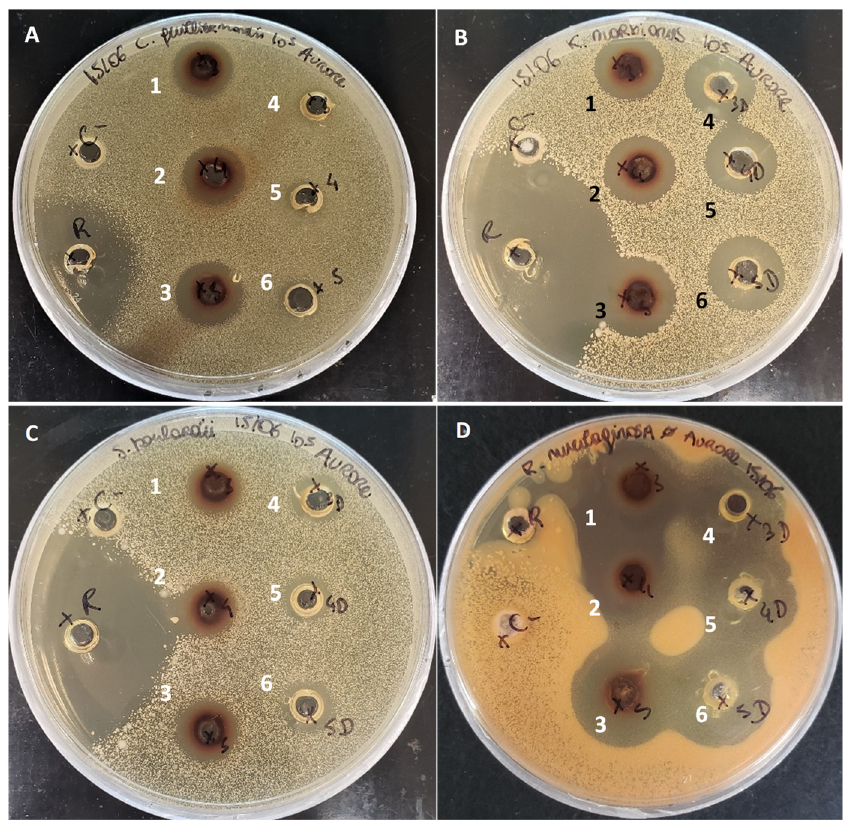
Figure 6. Inhibition zones for yeasts C. guilliermondii ( A ) K. marxianus ( B ) S. boulardii ( C ) R. mucilagi- nosa ( D ) distilled water (C –) and Reuterin (R). 1 2 and 3: Raw hydrolysate repetition 1 2 and 3; 4 5 and 6: Discolored hydrolysate repetition 1 2 and 3.